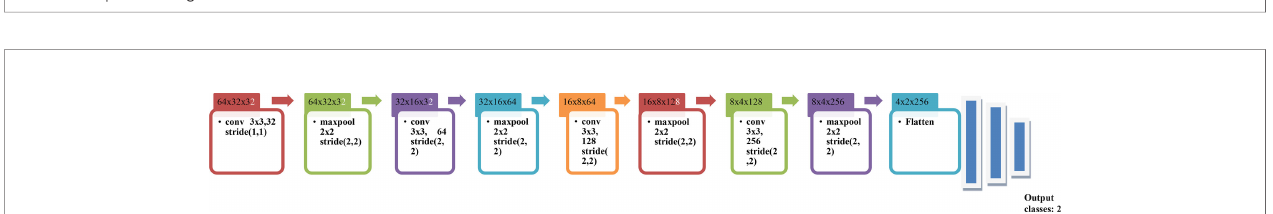
FIGURE 5 | Block diagram of the CNN Model.